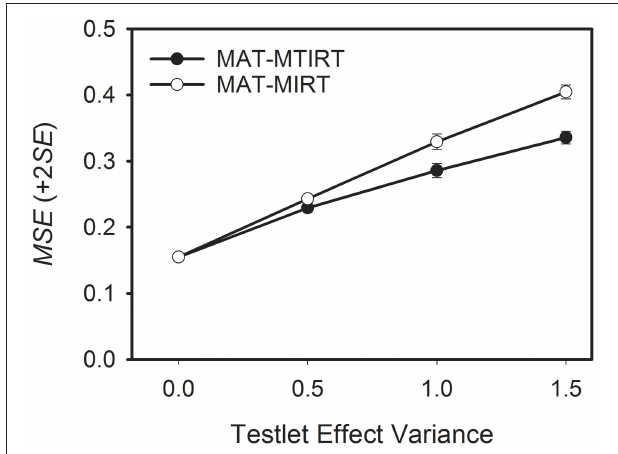
FIGURE 2 | Average mean square error ( MSE ) of the ability estimates obtained by MAT with the MTIRT and the MIRT model as a function of testlet effect variance. Testlet size = 6